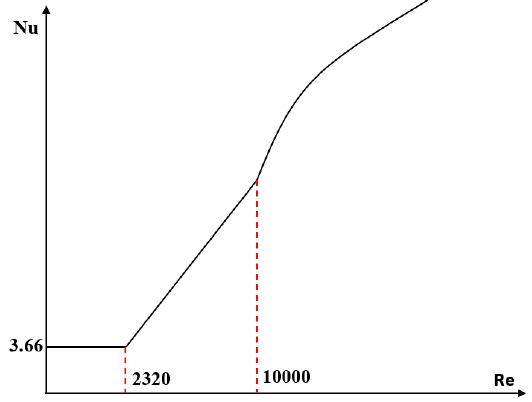
Figure 2. Calculation of the Nusselt number.